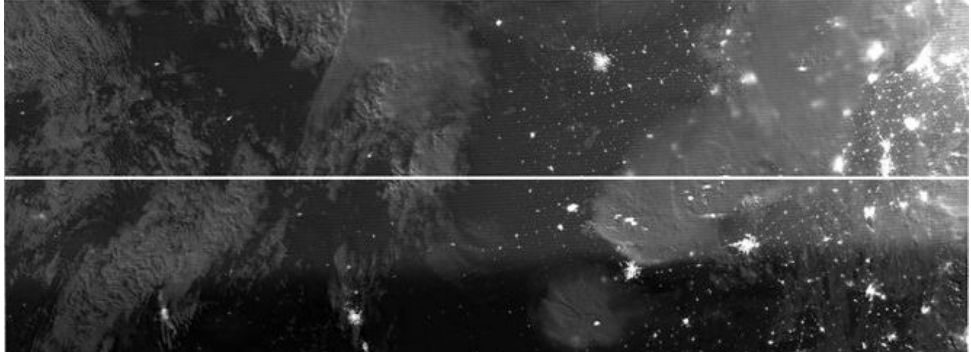
Figure 4. Two NCC granules with city lights, but otherwise consisting of airglow-only cloud features. This type of image is possible using the LUT that was expanded to allow for NCC to be produced under no-moon conditions.